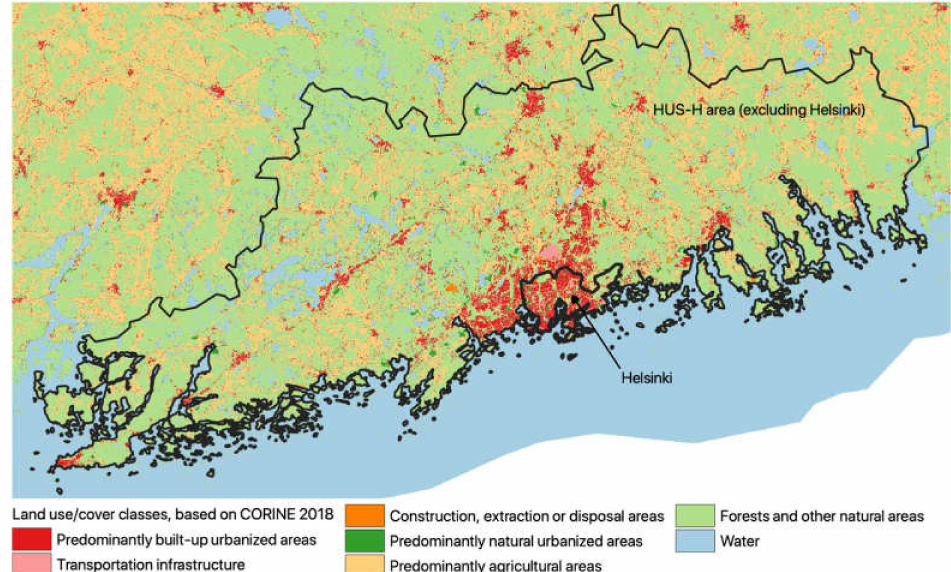
Figure 1. Overview of simplified CORINE 2018 land use/cover categories in the study areas: HUS is indicated by the outer black border; Helsinki by the inner black border; HUS-H area (HUS excluding Helsinki) by the area between the outer and inner borders. Land use/cover categories are indicated in the legend: red, orange or purple colours indicate predominantly urbanised areas, whereas yellow, green and blue colours indicate predominantly rural or natural